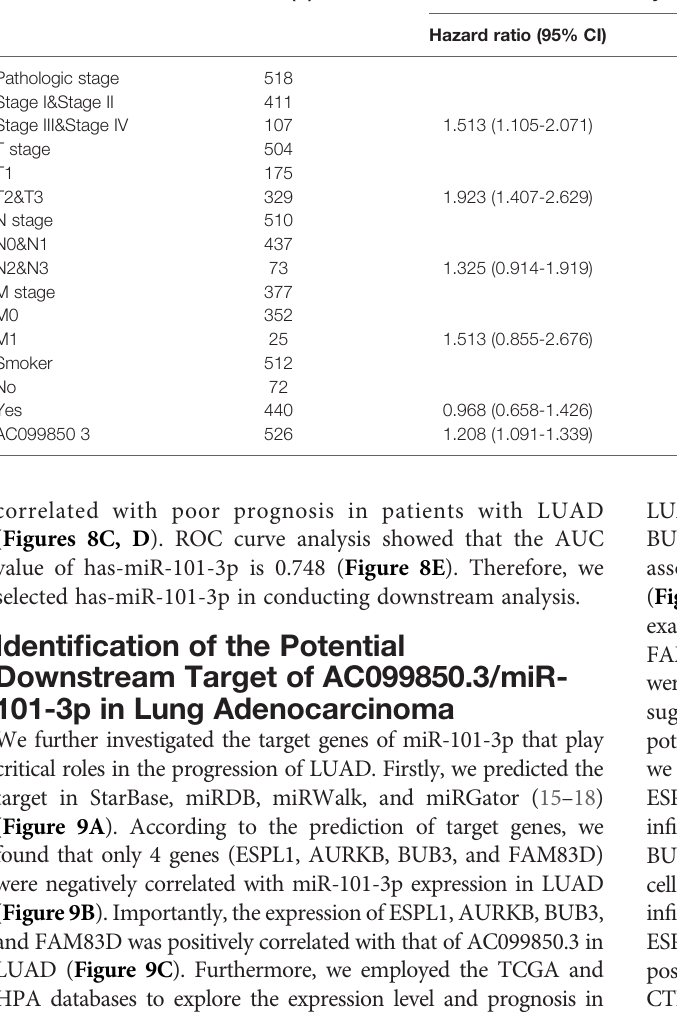
TABLE 5 | Univariate and multivariate Cox regression analyses of different parameters on PFS. Characteristics